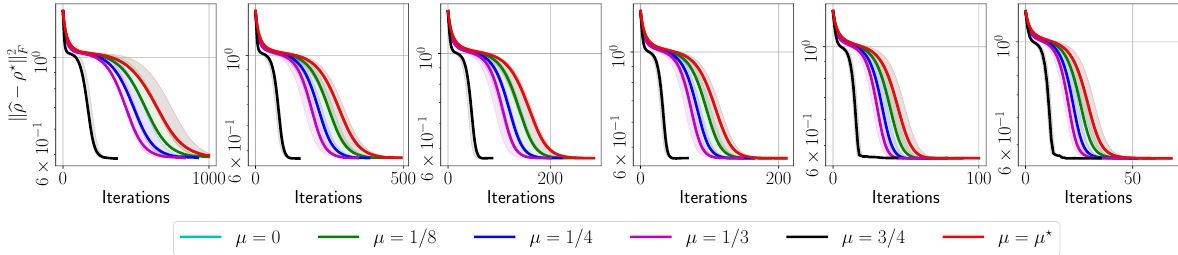
( 8 ) circuit using real measurements from −